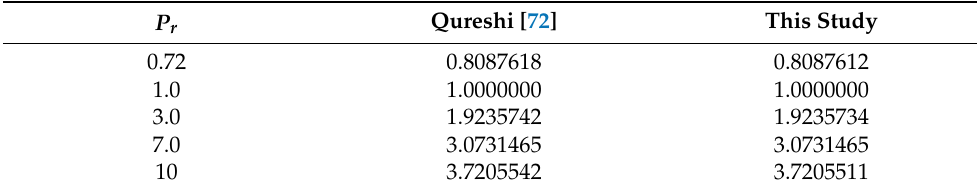
Table 1. Comparison of − θ (cid:48) ( 0 ) with alteration in Prandtl number, taking δ = Rd = λ T = Nt = γ 1 = γ 2 = γ 3 = 0 and Nb = 0 .